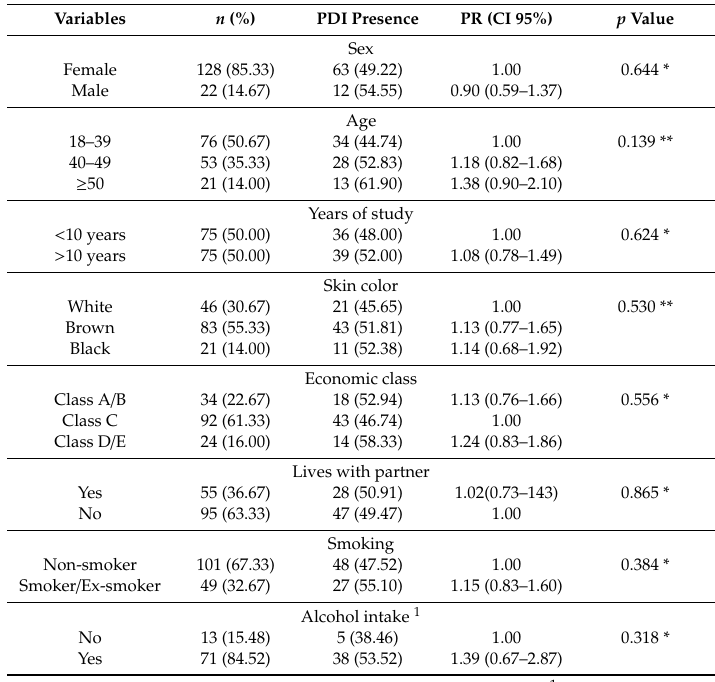
Table 2. Prevalence of Potential Drug Interactions (PDI) and its association with sociodemographic and lifestyle variables in adults with severe obesity ( n = 150).